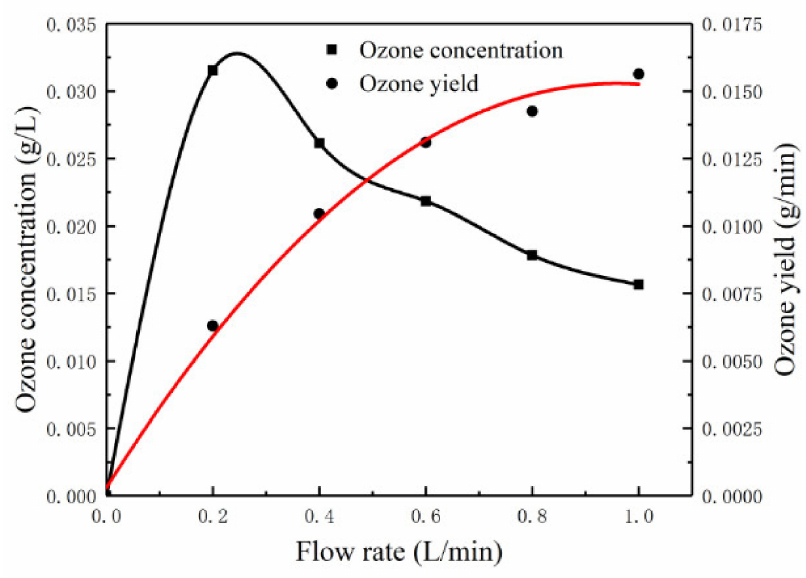
Figure 2. Relationship between gas flow rate and ozone concentration and yield. Finally, a 754PC UV–Vis spectrophotometer (Shanghai Jinghua Instrument Co., Ltd., China) and two quartz colorimetric cells with an optical path of 10 mm were used for determination of TDN in the detection